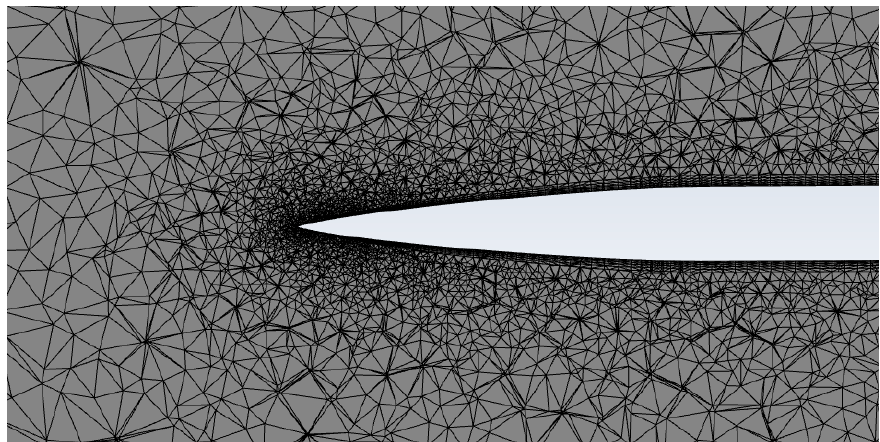
Figure 9. Cross-section of FLUENT mesh.